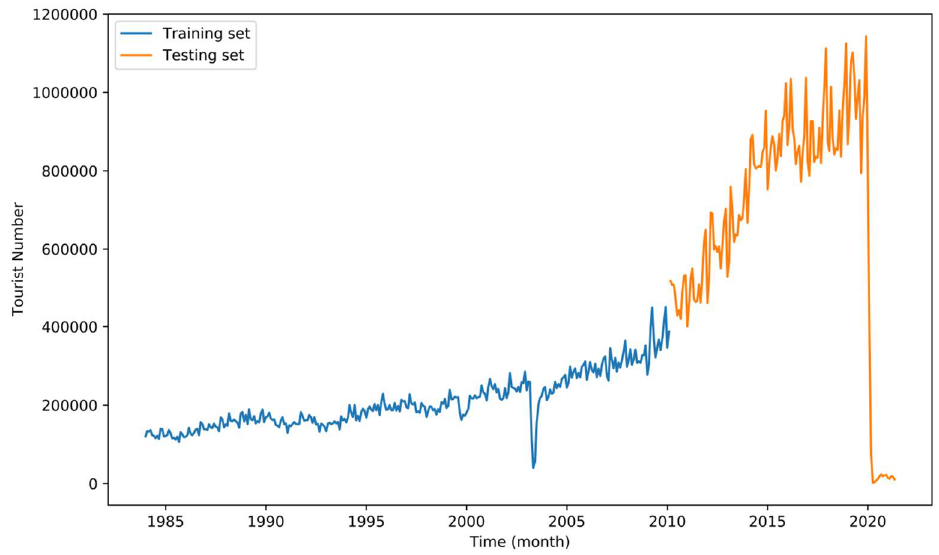
Figure 3. Monthly tourist number of Taiwan from January 1984 to May 2021.